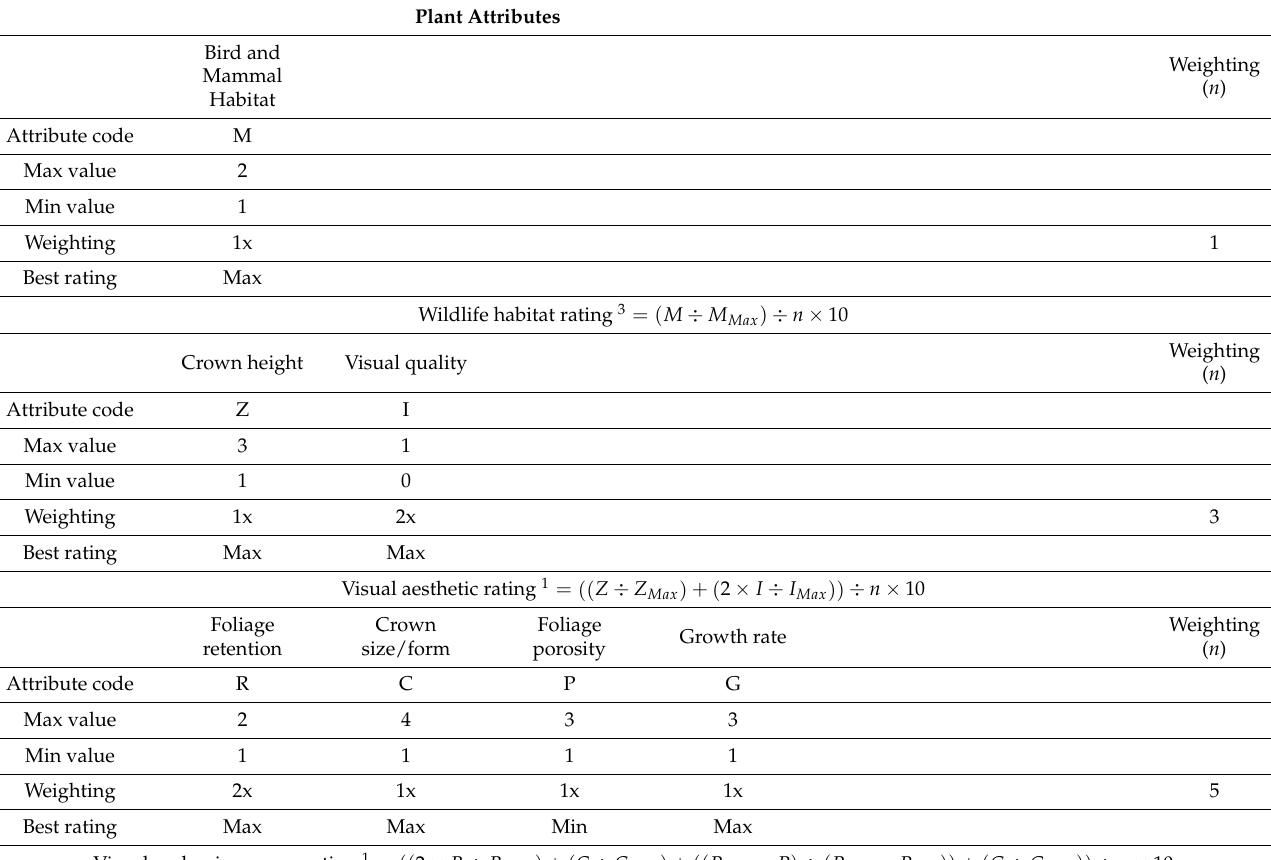
Table 3. Cont. Plant